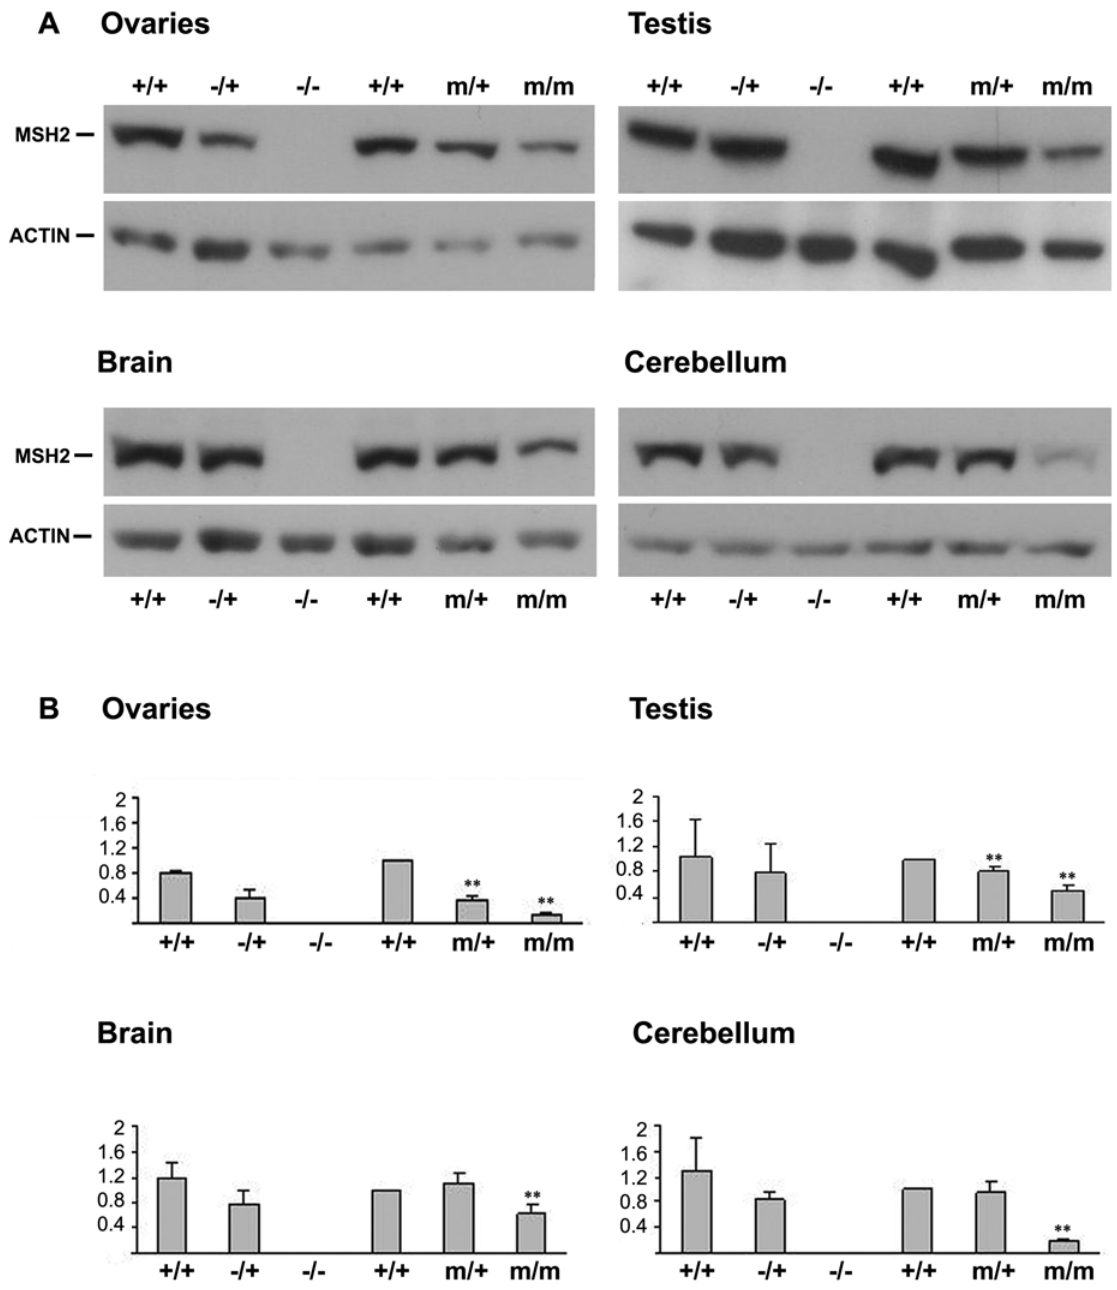
Figure 4. MSH2 protein levels in 3 to 4-month-old mice carrying different Msh2 genotypes. (A) Western blot analysis of MSH2 protein levels in ovaries, testis, brain and cerebellum from Msh2 + / + , Msh2 2 / + , Msh2 2 / 2 (C57BL/6J, 129/OLA, FVB), Msh2 + / + , Msh2 m/ + and Msh2 m/m ( . 90% C57BL/6J) mice. b -actin was used as a loading control. Each lane represents pooled protein extracts from three mice. MSH2: 104 kDa and b -actin: 6 42kDa. (B) The graphs show the quantitative analysis of MSH2 protein expression levels relative to b -actin in the tested tissues. The quantification has been performed by western blotting reproduced at least three times for each tissue. The x-axis shows MSH2/ b -actin ratio. For each graph, all values have been calculated considering the value of Msh2 + / + (C57BL/6J) as the reference value 1. **, p , 0.005. + / + , m/ + and m/m represent genotypes at the murine locus for Msh2 . + : wild-type allele; m, Msh2 G674A mutation. Error bars correspond to S.D.